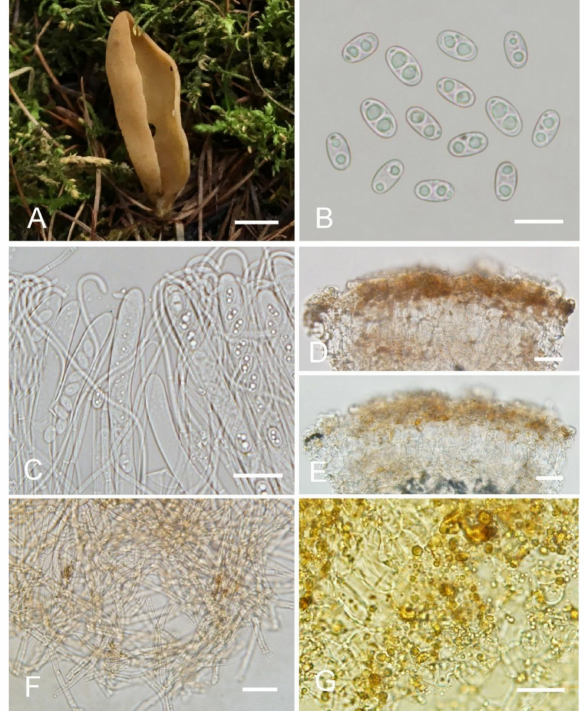
Figure 6. Otidea khakicolorata (BJTC FM107) ( A ) apothecia, ( B ) ascospores, ( C ) asci and paraphyses, ( D ) ectal excipulum in KOH, ( E ) ectal excipulum in water, ( F ) basal mycelium, and ( G ) amber drops on the outermost ectal excipulum cells in Melzer’s reagent. Scale bars: ( A ) = 0.5 cm, ( B ) = 10 µ m, ( C ) = 20 µ m, ( D , E ) = 25 µ m, ( F , G ) = 20 µ